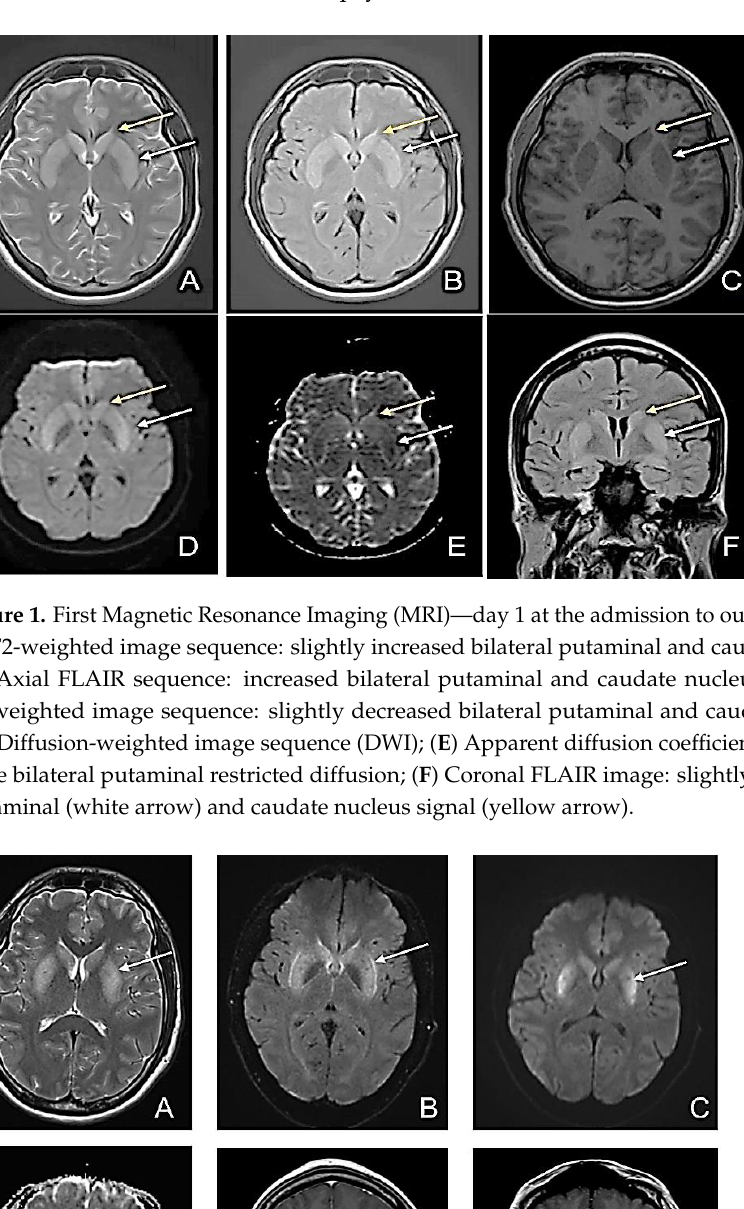
Figure 3. Third MRI — D11. ( A ) Axial T2-wi sequence: persistent high T2 signal intensity in posterior 2/3 of the putamen; ( B ) Axial FLAIR image: Symmetrical hyperintensity of the posterior 2/3 of the putamen (white arrow) and normal signal intensity of the caudate nucleus (yellow arrow); ( C ) Axial